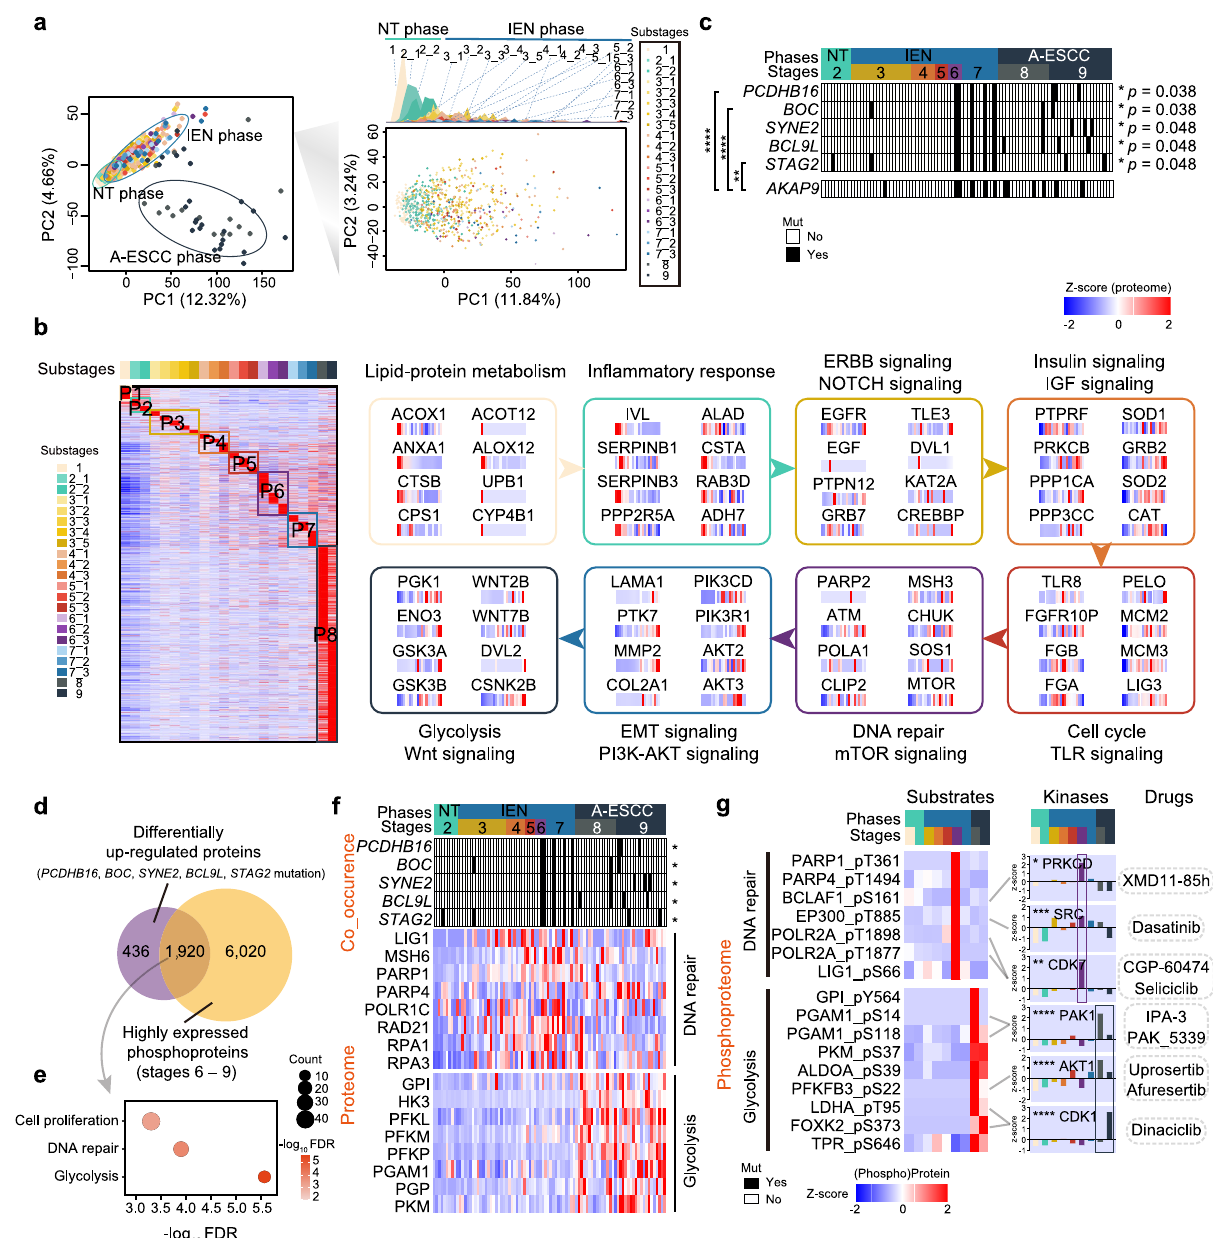
Fig. 4 | The temporal driver pathway waves in ESCC progression. a Principal component analysis (PCA) of the Fudan cohort. Left: PCA of all 786 ESCC samples (including NT phase, IEN phase, and A-ESCC phase); Right: PCA of 746 early ESCC samples (NT phase and IEN phase). b Heatmap analysis of the dynamic switches during the carcinogenesis of ESCC (Kruskal – Wallis test). Left: heatmap analysis of DEPsofthe22substagesinESCCprogression.Right:thedriverpathwaywavesof8 panelsinESCCprogression. c Themutationsaresigni fi cantlyassociatedwithstages in ESCC progression (two-sided Fisher ’ s exact test). The highlighted mutations (right) are exclusively co-mutations (two-sided Fisher ’ s exact test). The square directs to a subset of patient samples used for WES ( n =102). p values of the co- mutations with AKAP9 : **** p =3.7E – 5 ( PCDHB16 ), **** p =3.7E – 5 ( BOC ), ** p =1.7E – 3